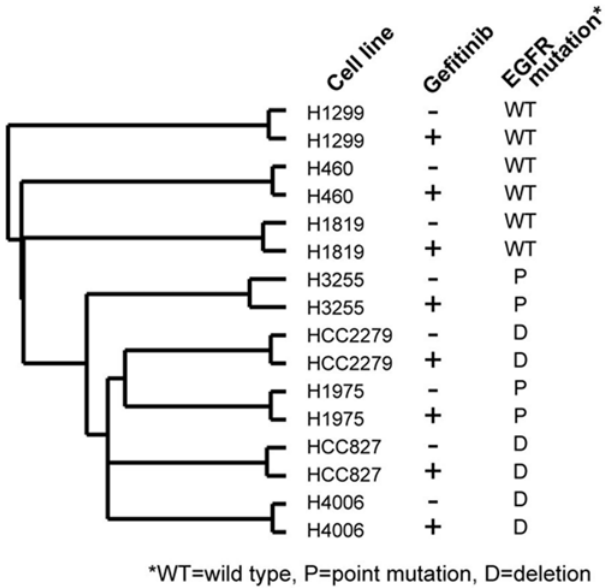
Figure 1. Hierarchical analysis of gene expression profiles in eight NSCLC cell lines. Dendrogram illustrating the relatedness of expression profiles from cell lines treated with ( + ) or without ( 2 ) gefitinib. The presence or absence of EGFR somatic mutations and the type of mutations, including L858R point mutation (P) or D 746–750 deletion mutation (D), are indicated. WT,